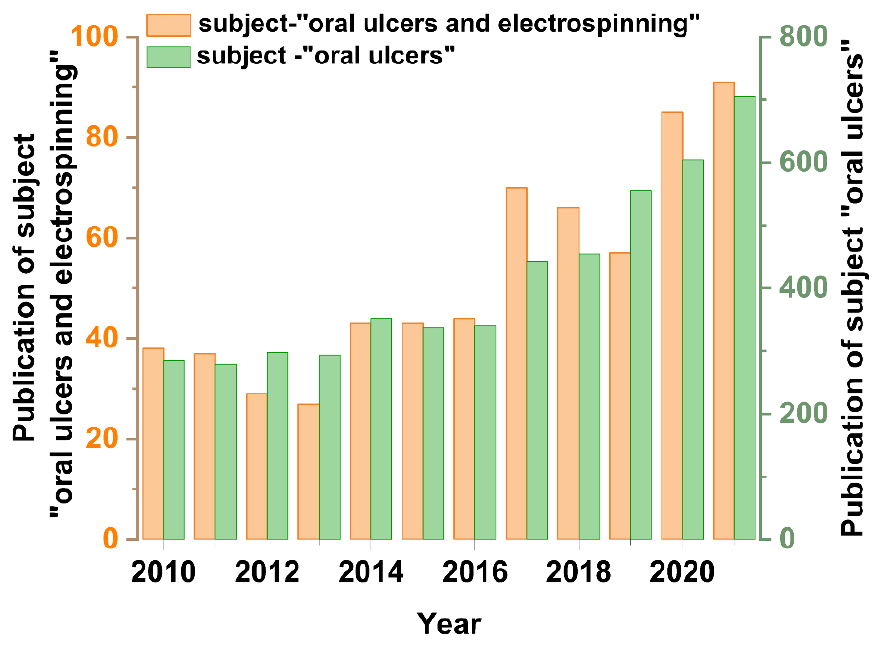
Figure 1. Number of publications on “oral ulcers” and “electrospinning technology for oral ulcers” since 2010.